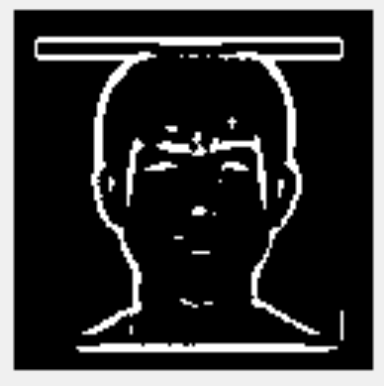
Figure 4. Example image that shows POIs.